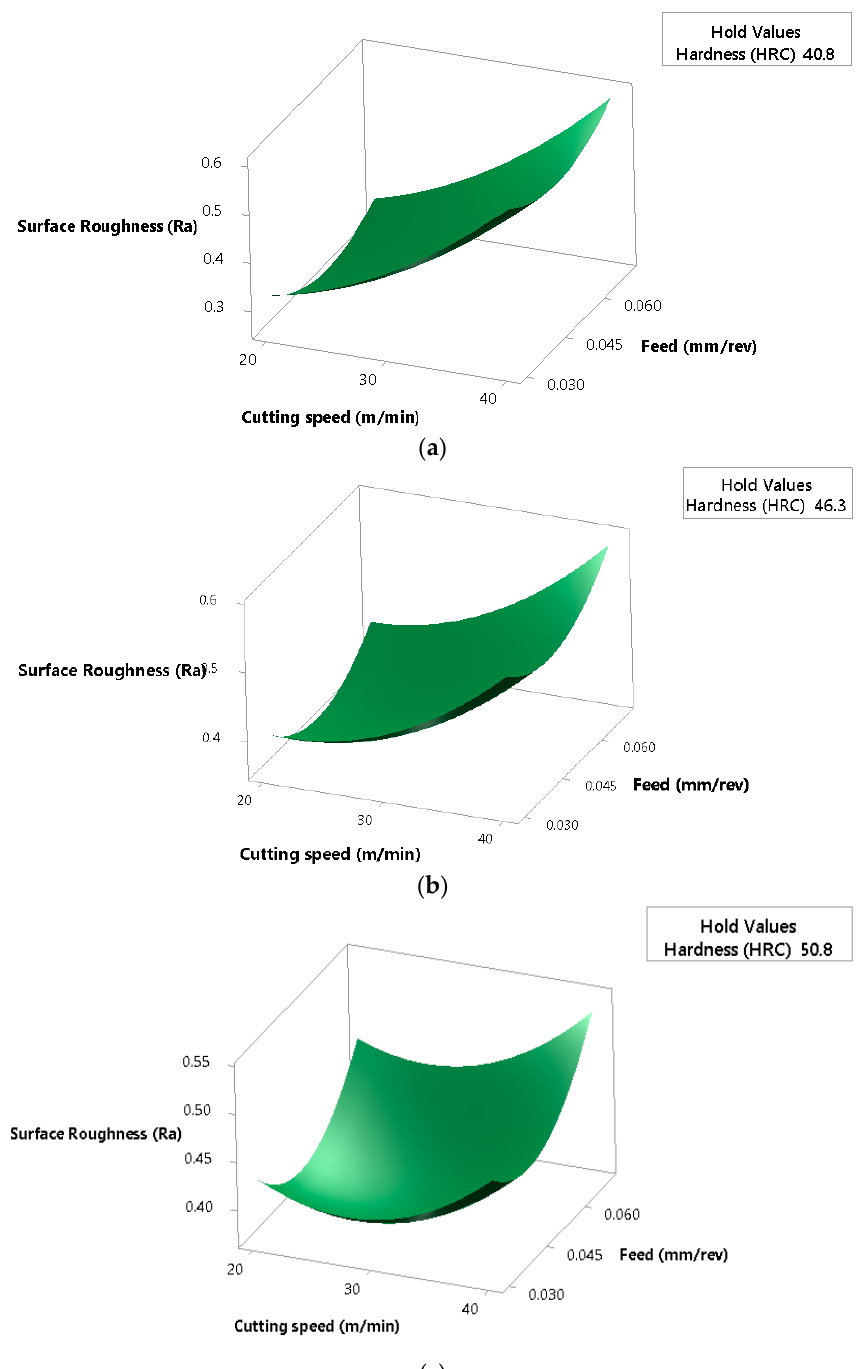
Figure 12. Surface plots of roughness (Ra) versus cutting speed and feed rate at hardness values of: ( a ) 41 HRC ( b ) 46 HRC and ( c ) 52